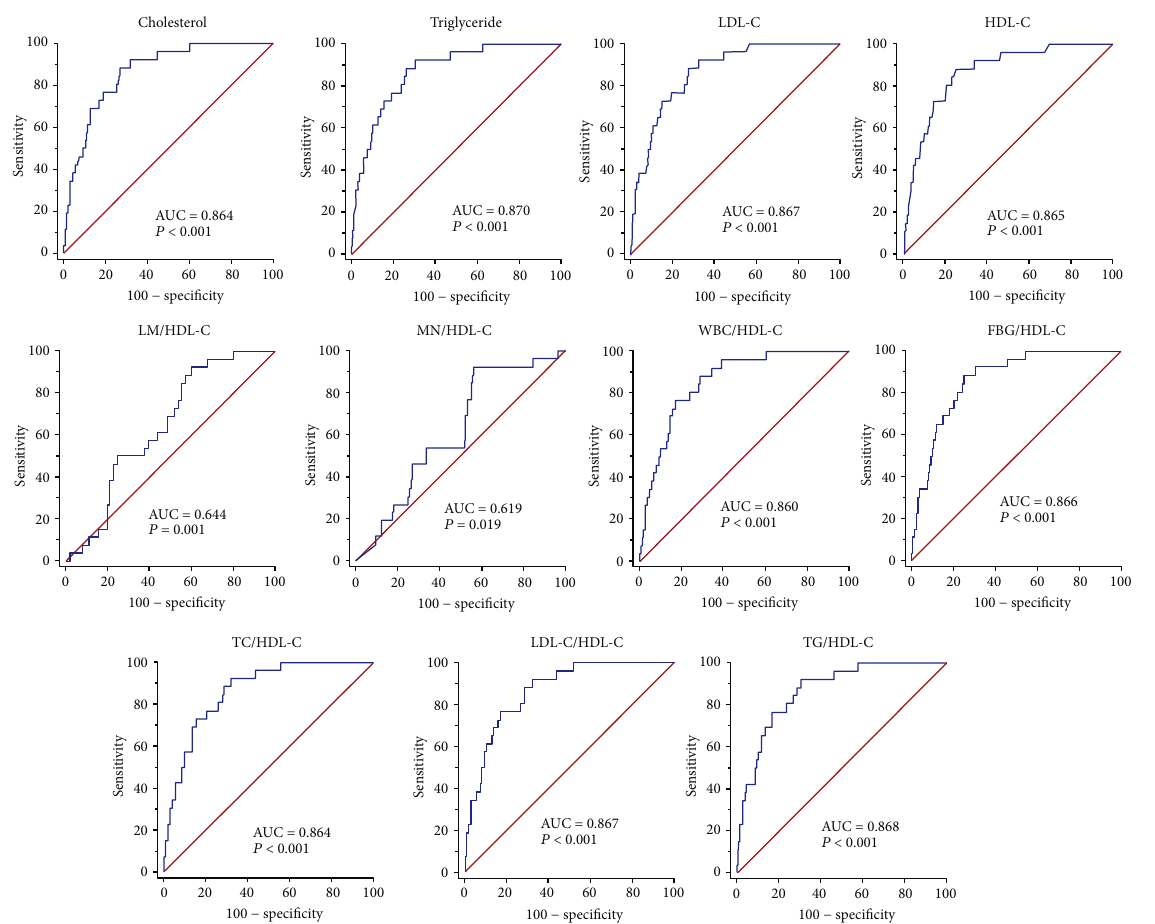
Figure 2: Receiver-operating characteristics curve for TC, TG, LDL-C, HDL-C, LM/HDL-C, MN/HDL-C, WBC/HDL-C, FBG/HDL-C, TC/ HDL-C, LDL-C/HDL-C, and TG/HDL-C. FBG: fasting blood glucose; HDL-C: high-density lipoprotein-cholesterol; LDL-C: low-density lipoprotein-cholesterol; LM: lymphocyte; MN: monocyte; TC: total cholesterol; TG: triglyceride; WBC: white blood